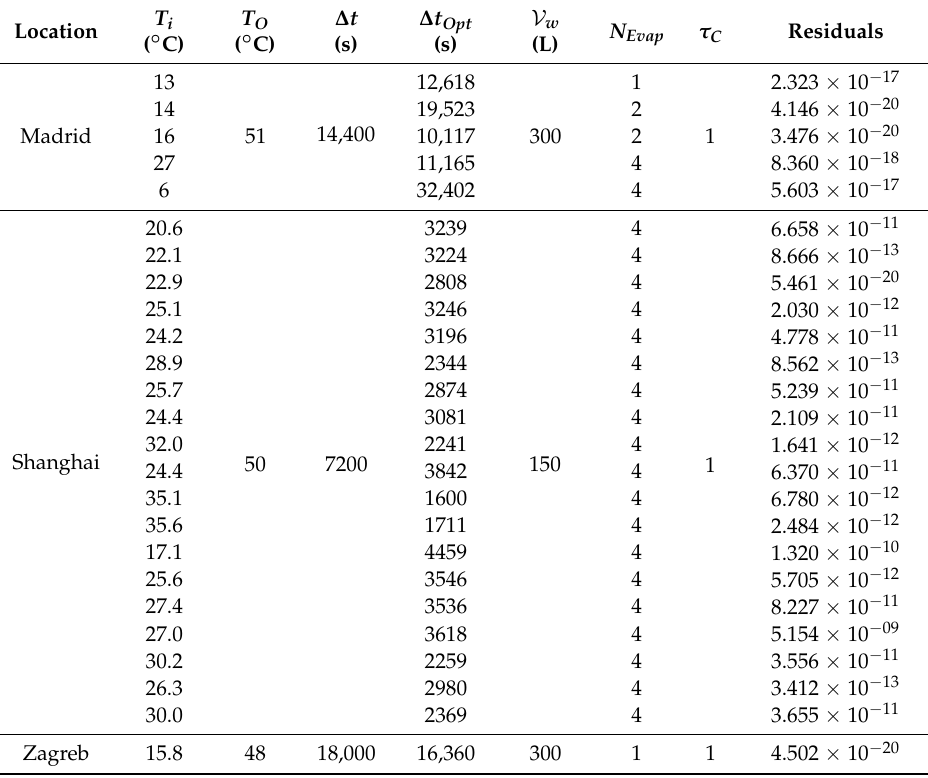
Table 7. GA-based modelling/optimization results.